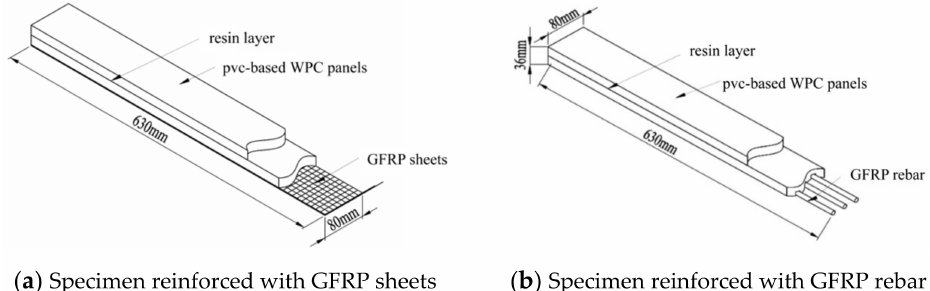
Figure 1. Design of GFRP-sheets- and rebar-reinforced WPCs.